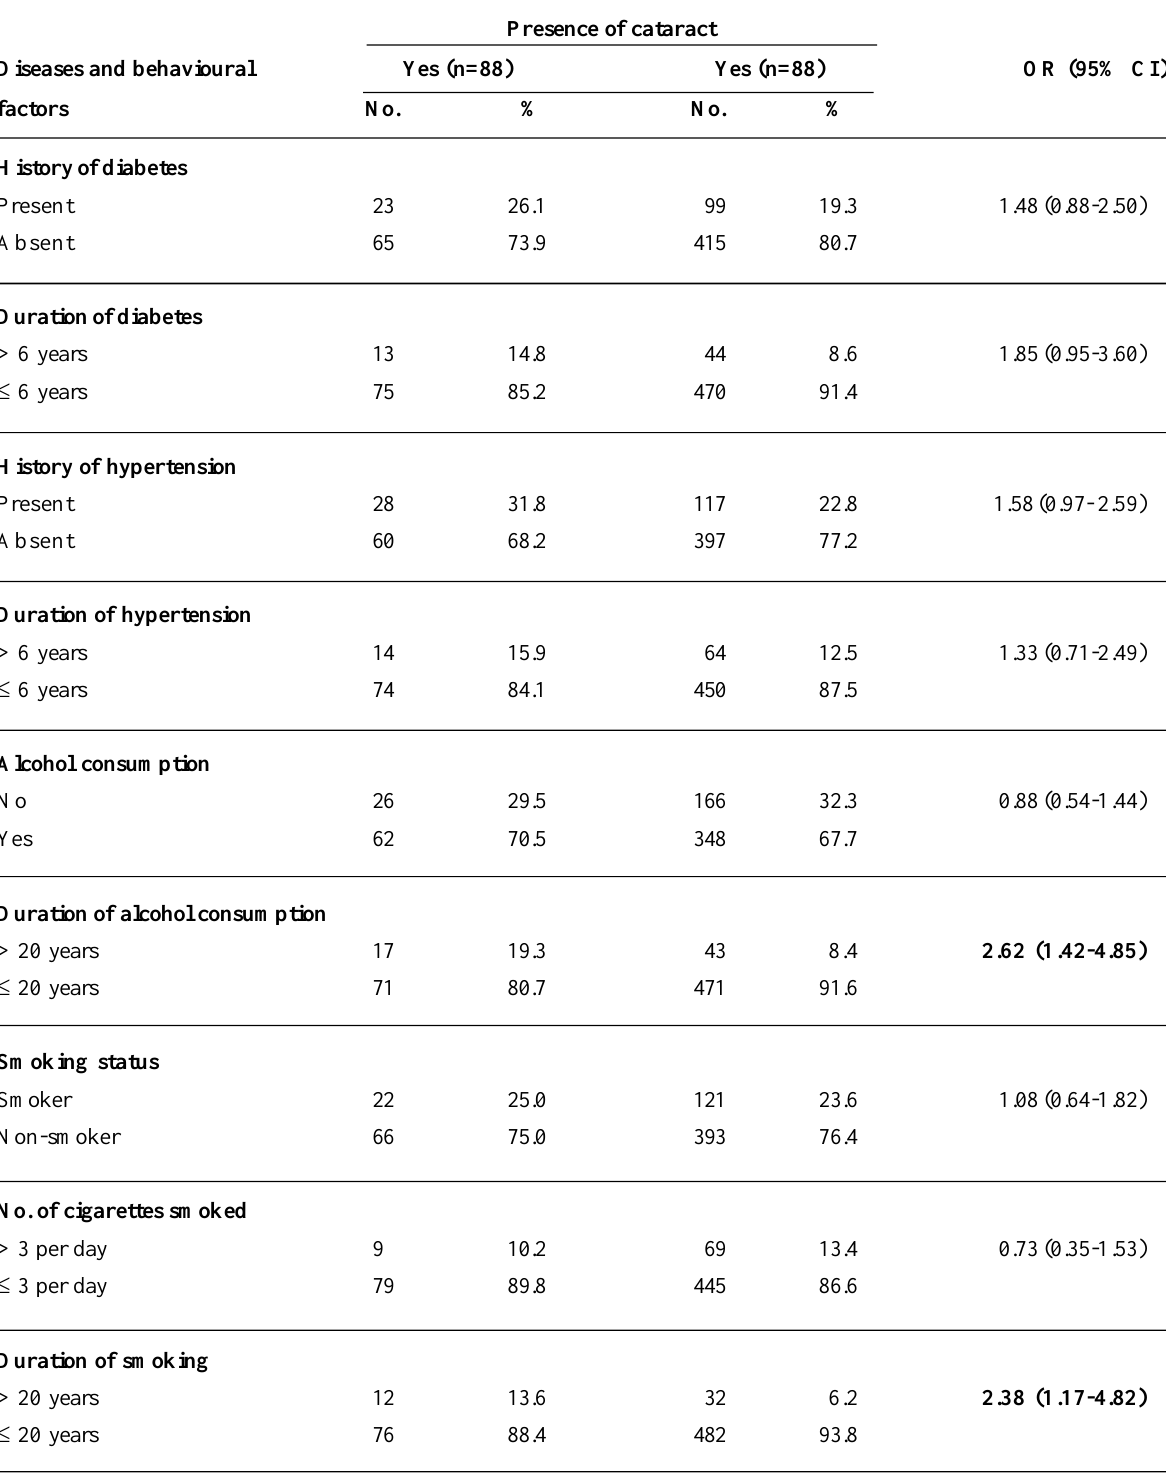
Table 2. Distribution of the study sample by status of cataract, other diseases and behavioural factors Presence of